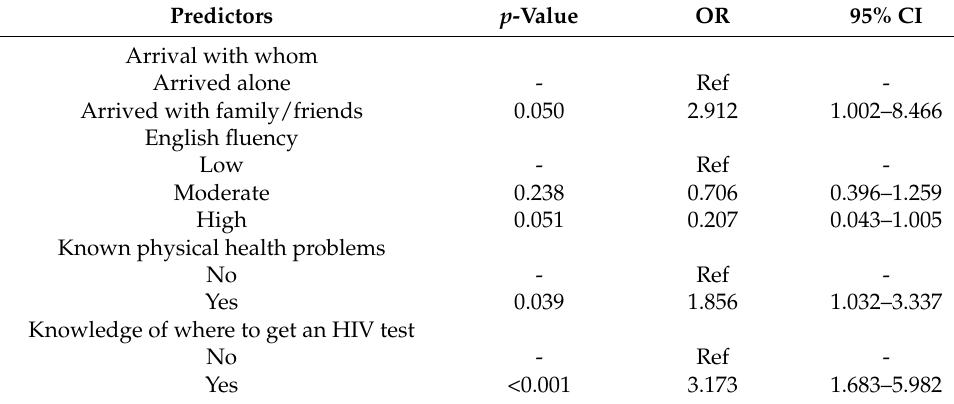
Table 4. Correlates of having received an HIV test while in Trinidad.